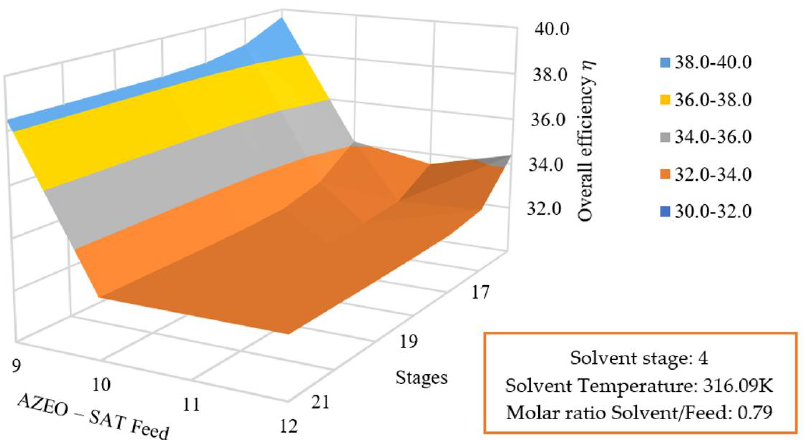
Figure 7. Variation of the azeotrope feed and the number of stages on the overall efficiency of the process.